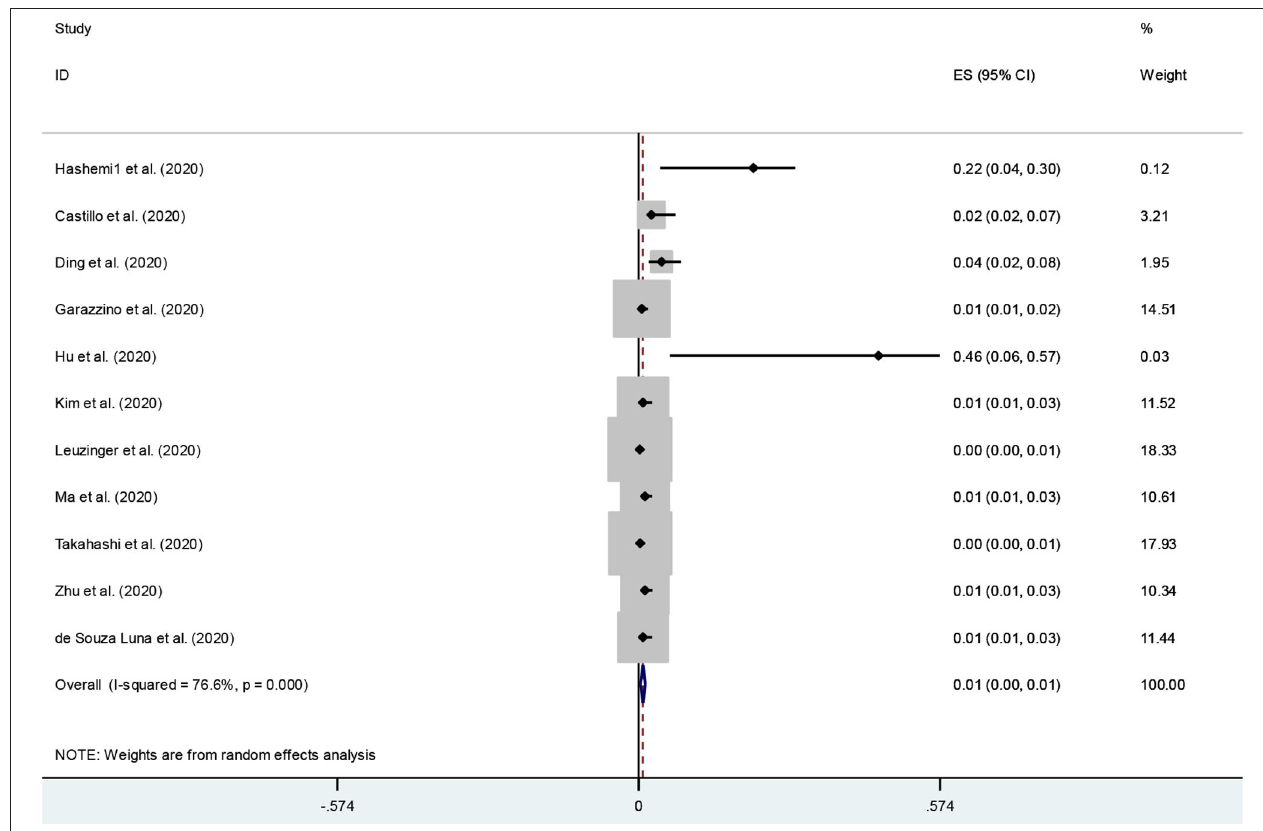
FIGURE 2 | Forest plot of the meta-analysis of data from single studies.